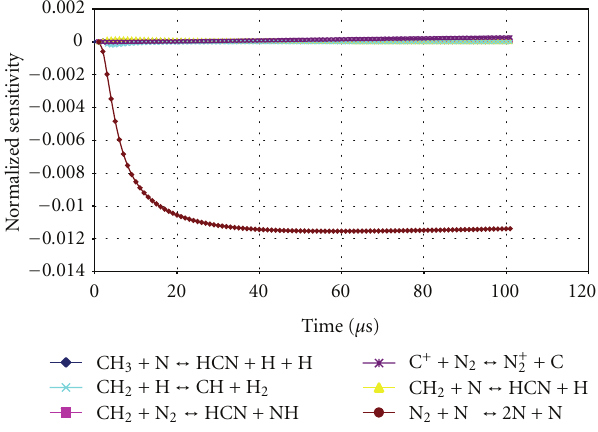
Figure 1: CN sensitivity coe ffi cient. Figure 2: Temperature sensitivity coe ffi cient.